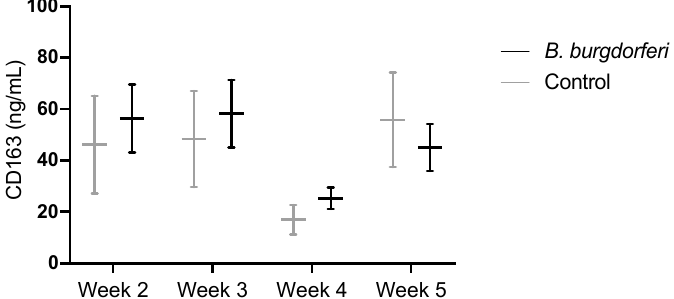
Figure 5. CD163 plasma levels (ng/mL) in a murine model of Lyme arthritis. Mice were infected with 10 6 B. burgdorferi intradermally in the lower back, and cheek blood was collected at week 2, 3, 4 ( n = 8) and 5 ( n = 15) post-infection. Data are presented as mean ± SEM.